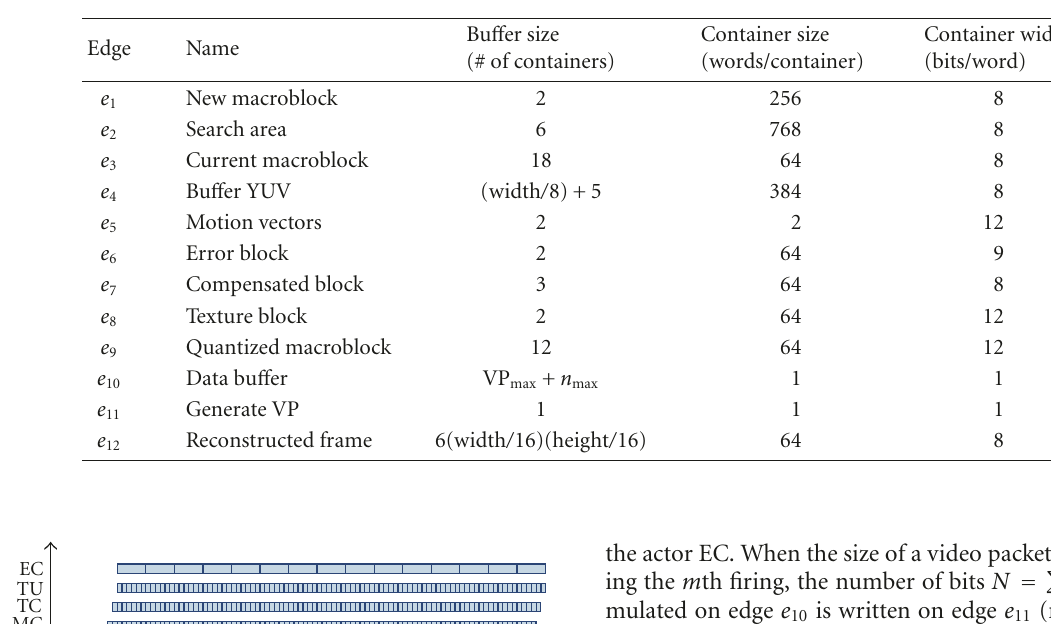
Table 3: Bu ff er and token size of all edges.